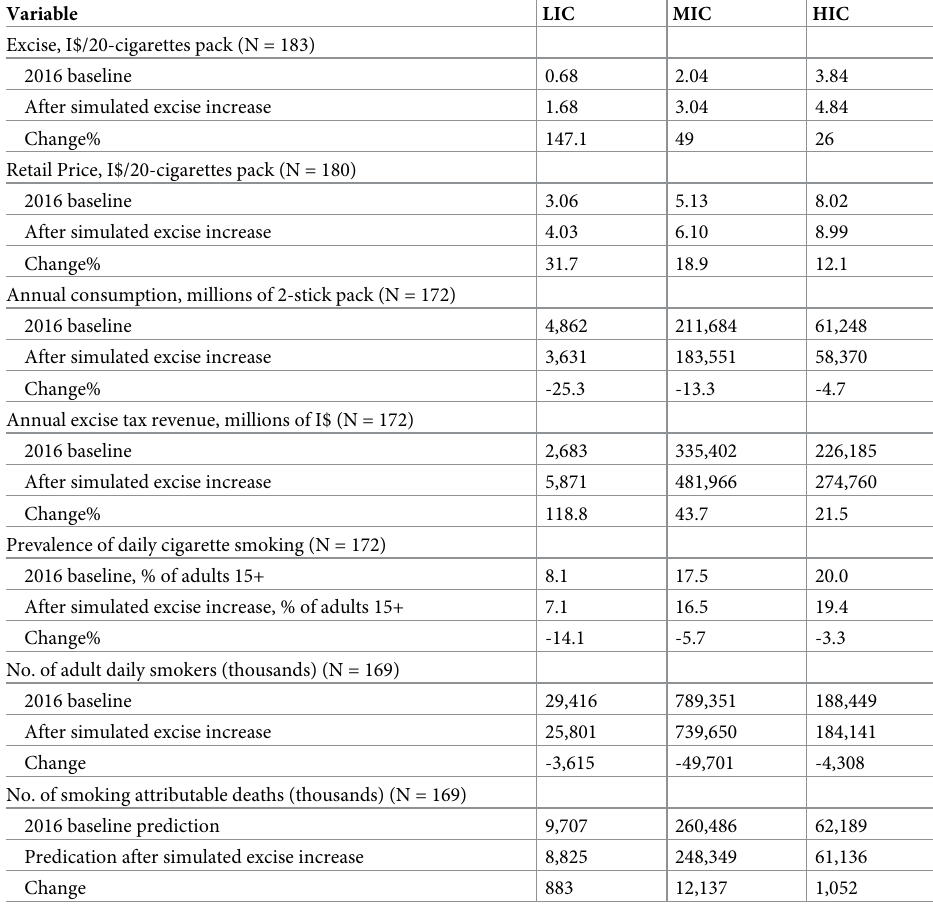
Table 2. Simulation results due to an I$1 excise tax increase, 2016.